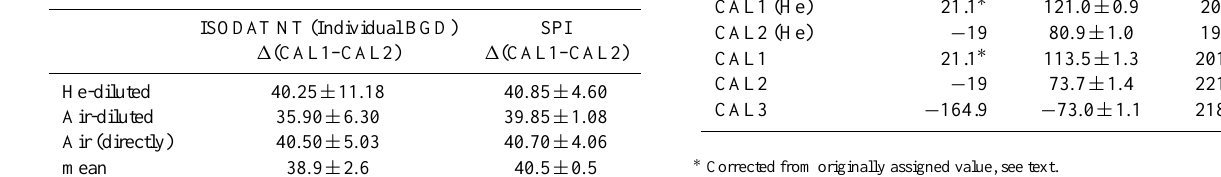
∗ Corrected from originally assigned value, see